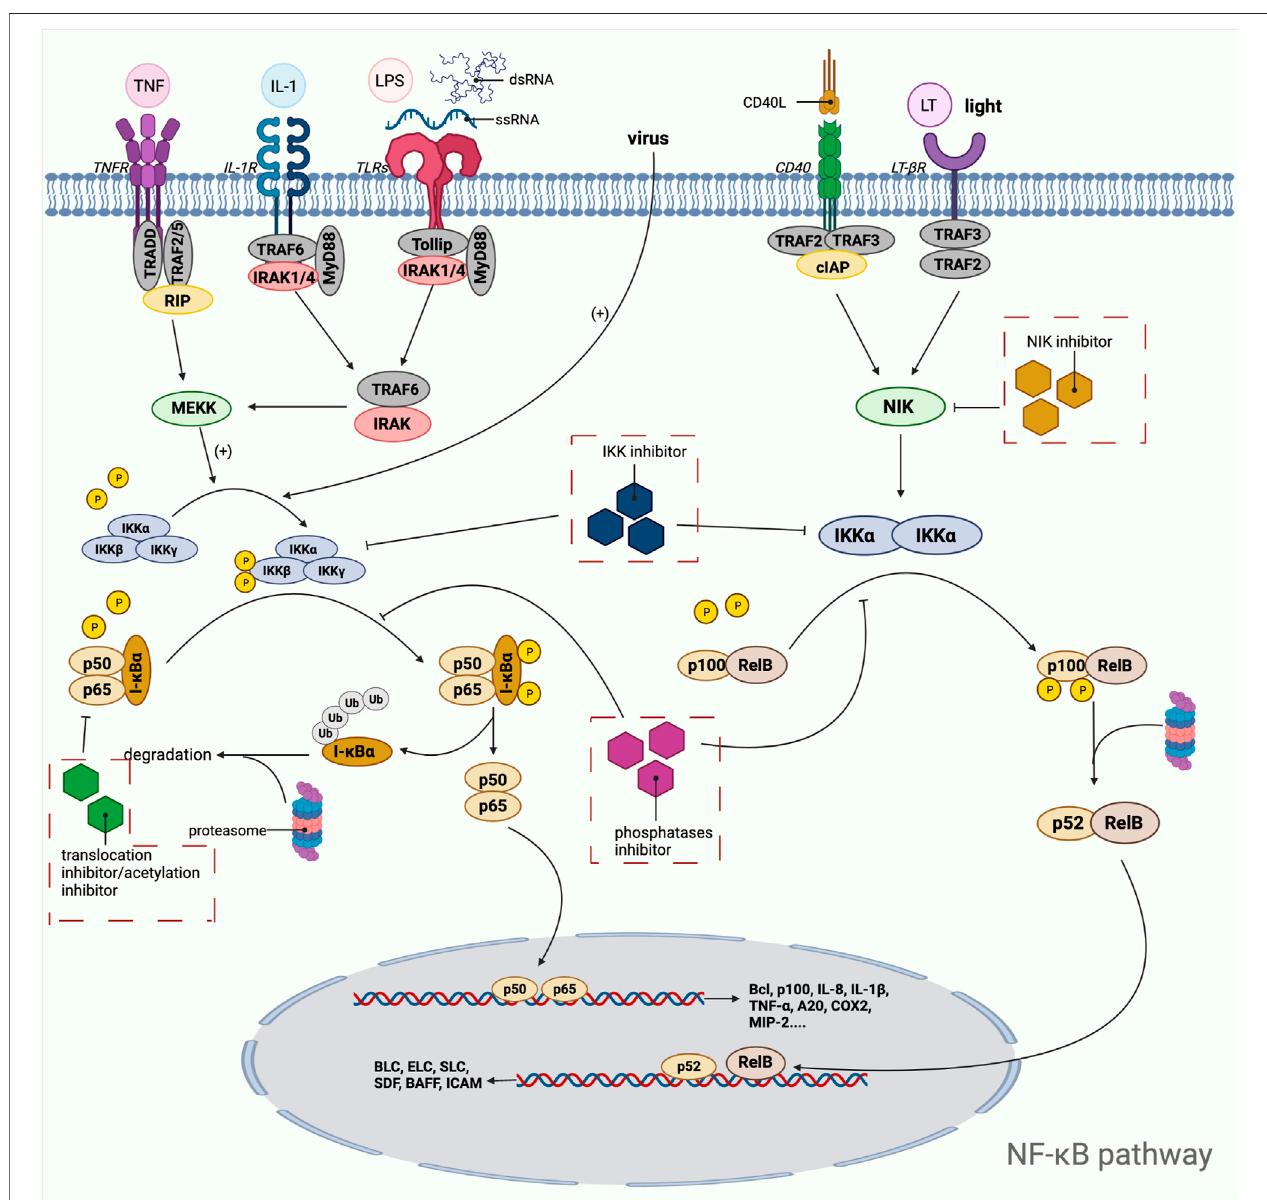
FIGURE 2 | Mechanistic map of the NF- κ B signaling pathway. BAFF, B-lymphocyte activating factor; Bcl, B-cell lymphoma; BLC, blood lactic acid; cIAP, cytoplasmic inhibitor apoptosisprotein; COX2, cyclooxygenase 2; ELC, ELongin C; ICAM, intercellular cell adhesion molecule; IL, interleukin; IRAK, interleukin-1 receptor-associated kinase; LPS, lipopolysaccharide; LT, Leukotriene; MIP, macrophage in fl ammatory protein; MyD: myeloid differentiation factor; RIP, receptor- interacting protein; SDF, stromal cell-derived factor; SLC, secondary lymphoid tissue chemokine; TNF, tumor necrosis factor; TRADD, TNF receptor-associated death domain; TRAF, tumor necrosis factor receptor associated factor The fi gure is created with BioRender.com.